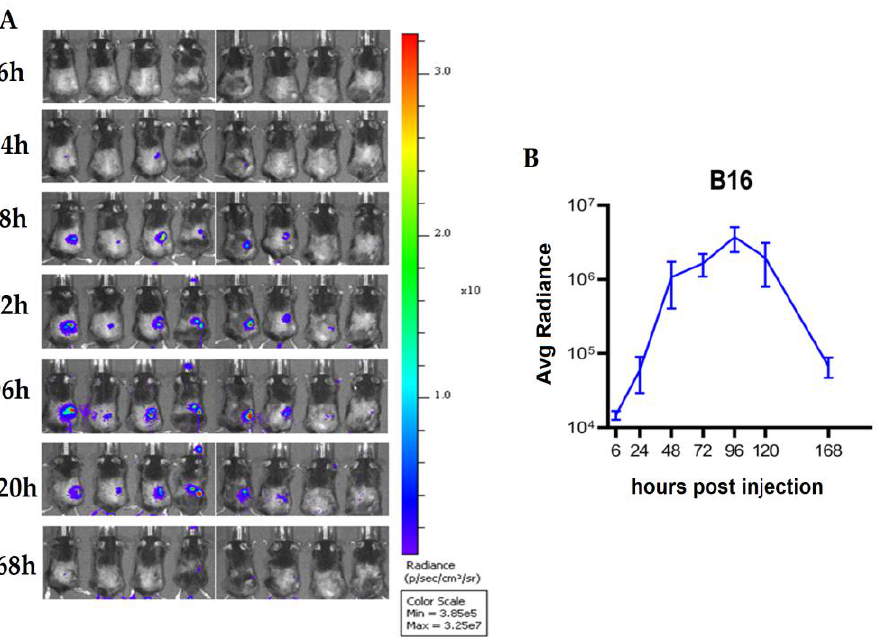
Figure 6. In vivo imaging. Virus detection by IVIS through time after injection of LIVP-FLuc-RFP to the B16 syngeneic mice. ( A ) Bioluminescence imaging of mice bearing B16 melanoma tumors. ( B ) Average radiance after virus injection; bioluminescence was detected up to 168 h after virus injection, and the maximum expression of luciferase was observed 96 h after infection.